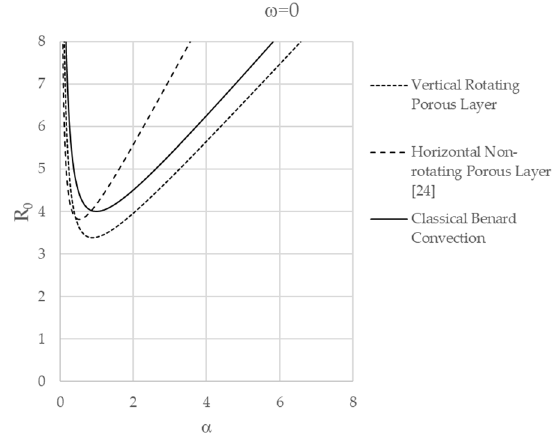
Figure 4. Comparison of characteristic Rayleigh number curves for the horizontal non-rotating porous layer [24], and vertical rotating porous layer, with internal heat generation, to the classical Benard convection characteristic curves. α denotes the wavenumber.